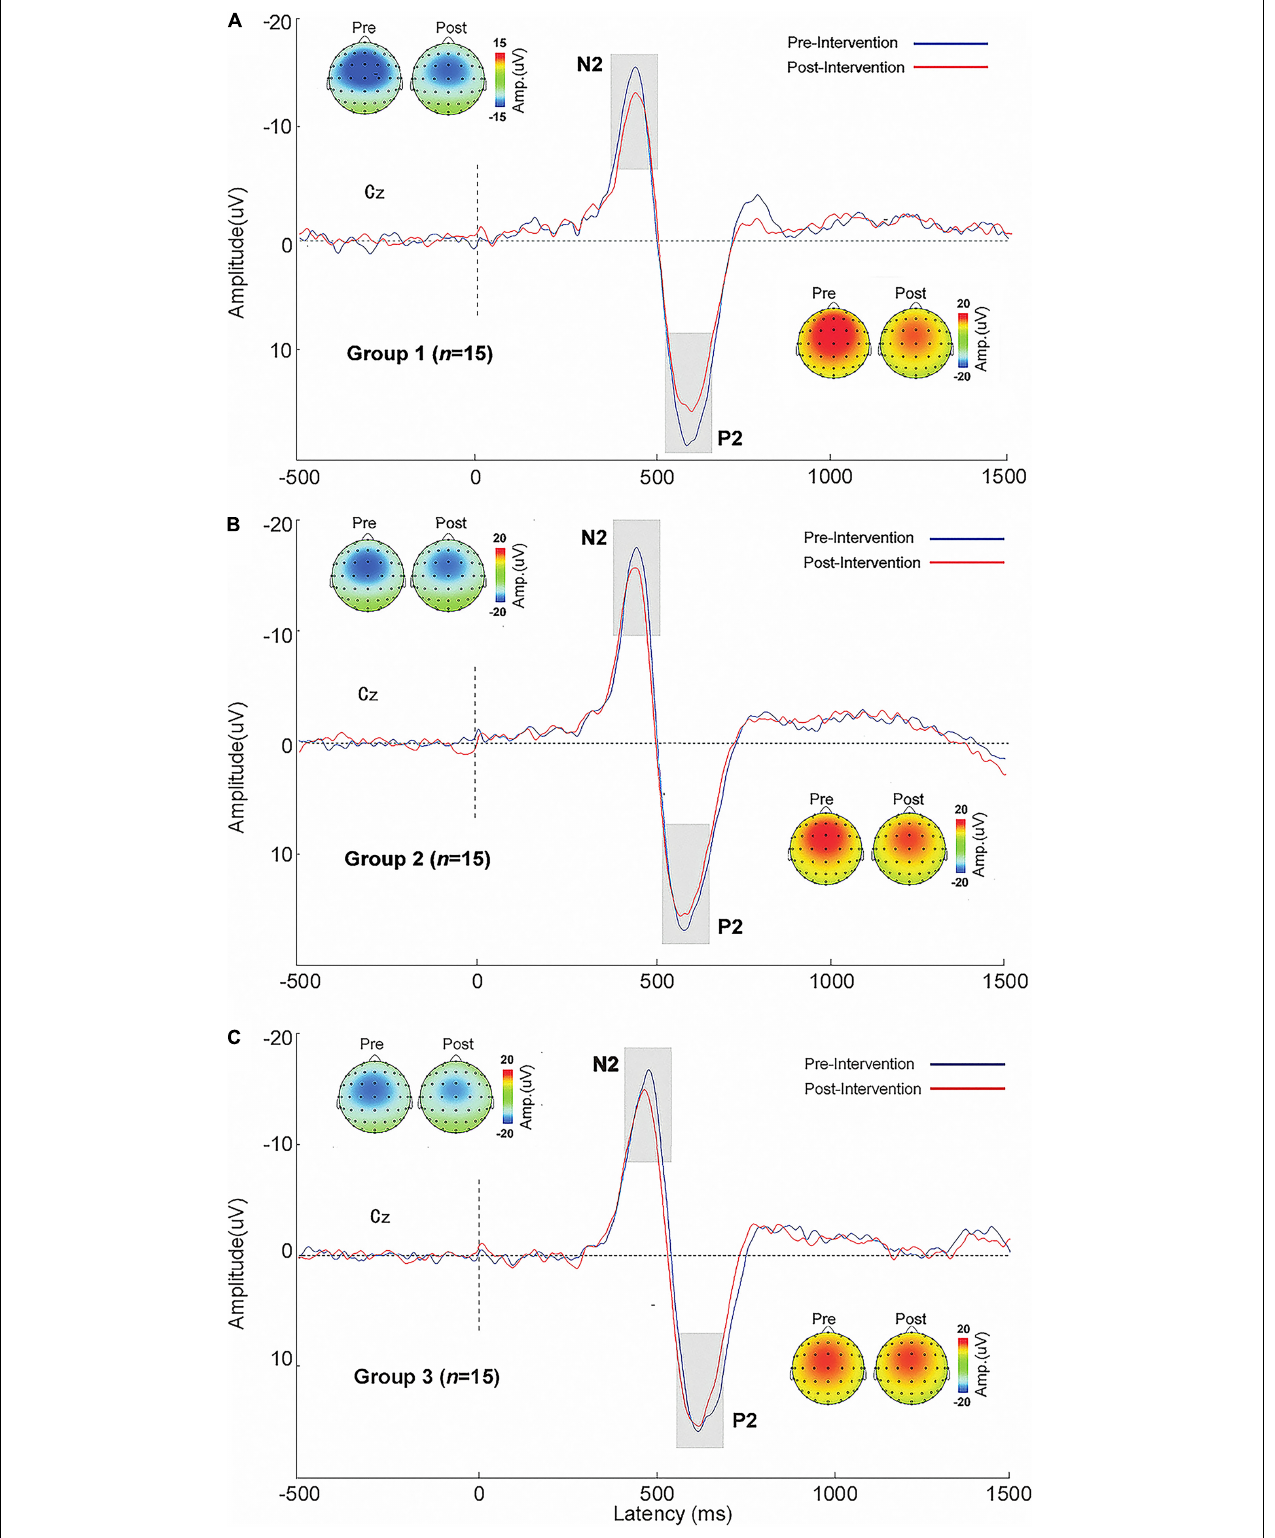
FIGURE 6 | Contact heat-evoked potential waveforms and N2 and P2 topographic maps of the central parietal electrode (Cz) in the three groups before and after intervention. (A) Group 1. (B) Group 2. (C) Group 3. Pre, pretest; Post, posttest.